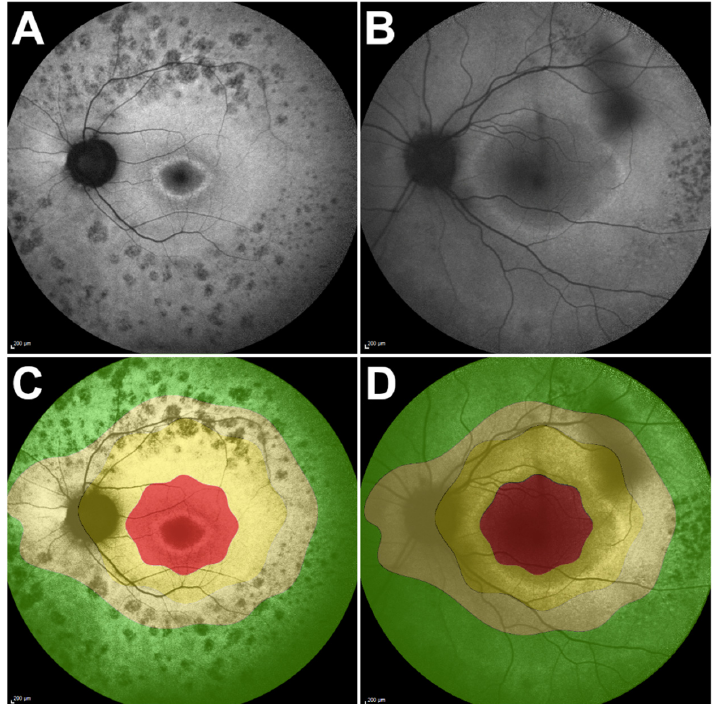
Figure 4. Retintis pigmentosa autofluorescent ring and its correlation with cone photoreceptor cells in the retina. ( A , B ) Autofluorescence images of P18 and P22, respectively. Note the position of the autofluorescent ring and its relation to cone photoreceptor cell distribution ( C , D ). Red, high cone density; yellow, medium cone density; green, low cone density. In P18 ( C ), the ring falls in the high cone density zone (red), as opposed to the medium density zone (yellow) in P22. As such, the P18 ring constriction has more impact in the 30 Hz flicker electroretinogram response than the similar constriction for P22.